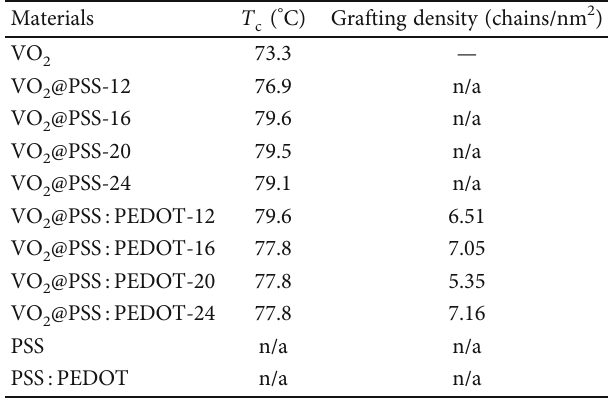
Table 3: The critical transition temperature ( T particles and density values of VO 2